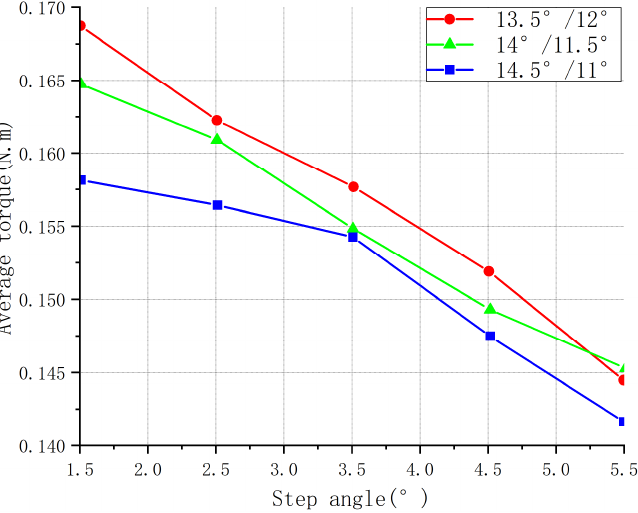
Figure 6. Average torque of different step angles for three parameter combinations.